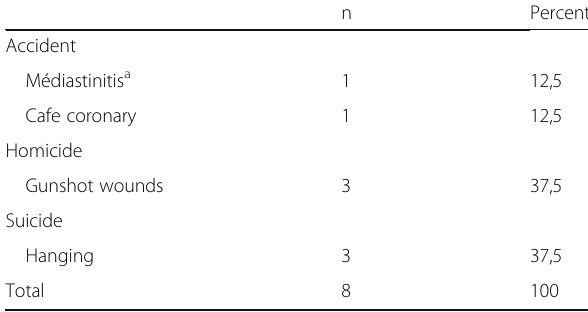
Table 2 Distribution of deaths of violent